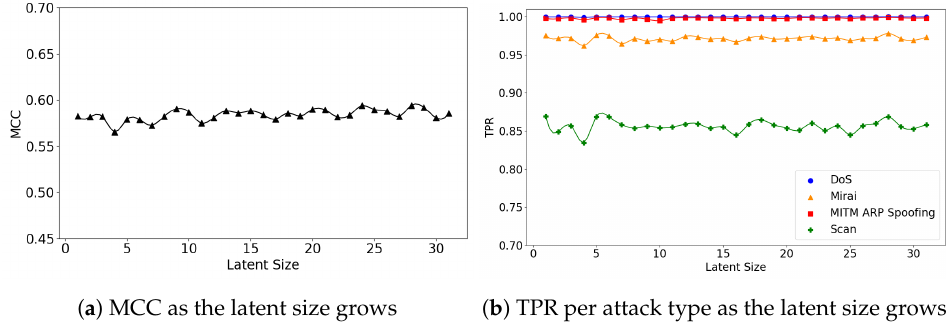
Figure 9. The results of evaluation using the IoTID20 dataset when the (5,64) model is employed.